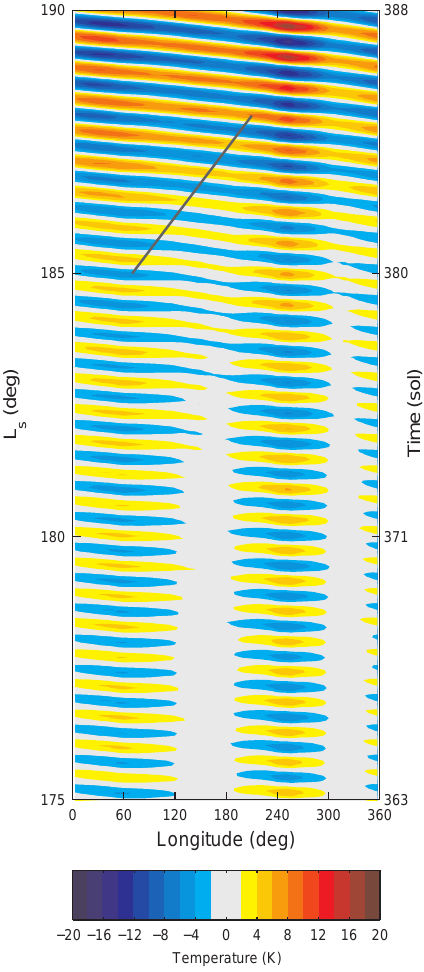
Fig. 7. As in Fig. 6 for a physical reconstruction considering low- order EOFs only, as listed in Table